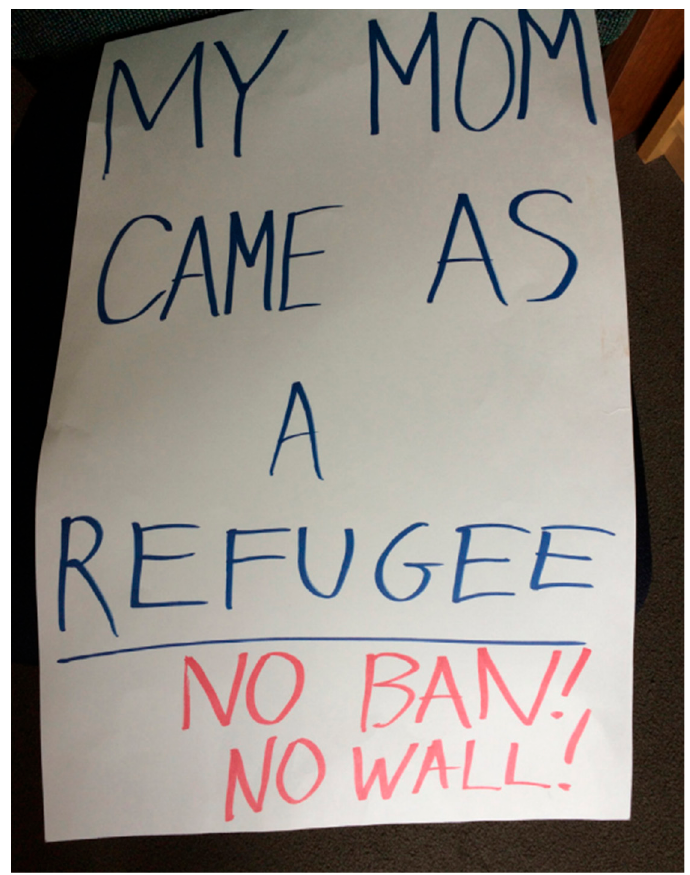
Figure 1. Sign carried by author at Muslim ban protest, San Diego, January 2017.